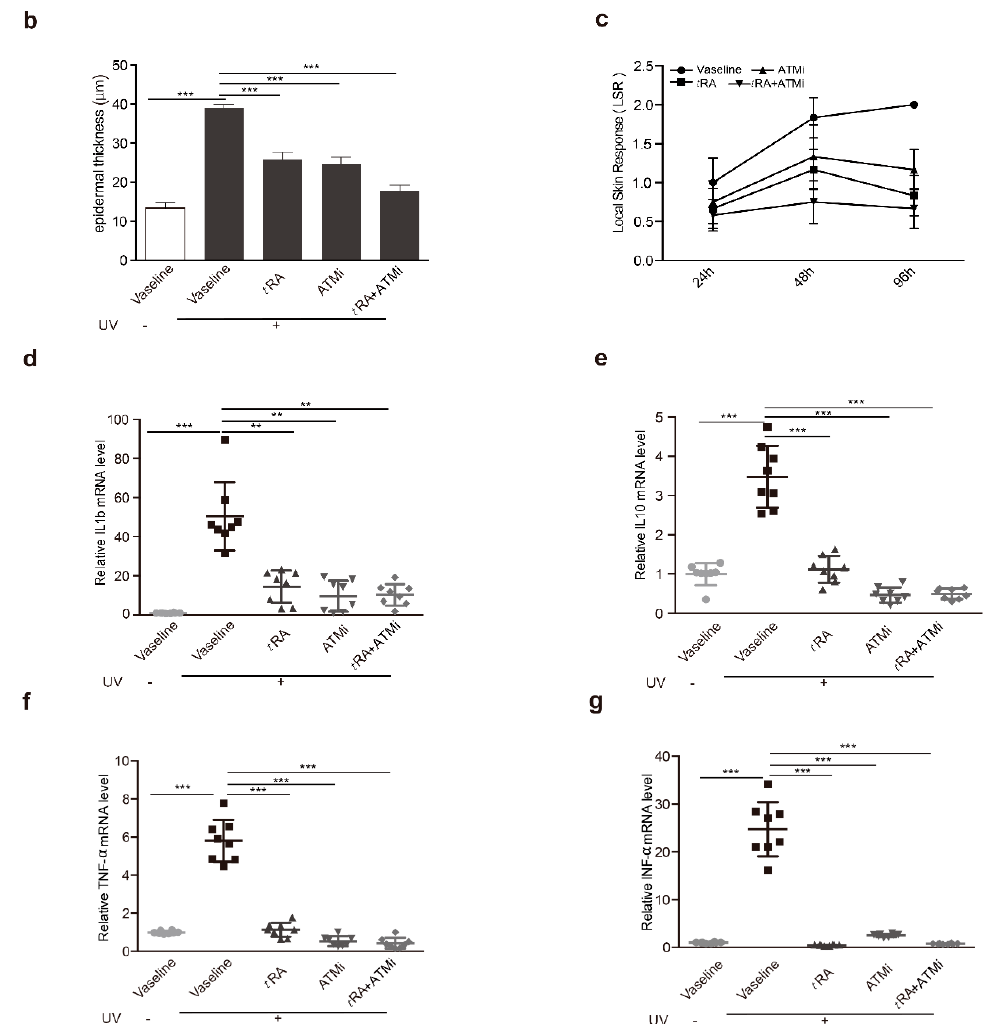
Figure 5. t RA and ATMi alleviated thickening and the inflammatory response of mice skin exposed to UV. ( a ) Representative bare skin (upper panel) and Masson-stained skin sections (lower panel) of C57BL/6 mice exposed to indicated treatments. ( b ) Analysis of epidermal thickness; each section was measured three times at different positions. Data are presented as means ± SEM. ( c ) Quantification of skin response to UV radiation with the LSR (local skin response) grading scale. ( d ) mRNA levels of IL-1b were determined via RT-PCR. ( e ) mRNA levels of IL-10 were determined via RT-PCR. ( f ) mRNA levels of TNF- α were determined via RT-PCR. ( g ) mRNA levels of INF- α were determined via RT-PCR. Data are presented as means ± SEM ( n = 8, ** p < 0.01, *** p < 0.001).